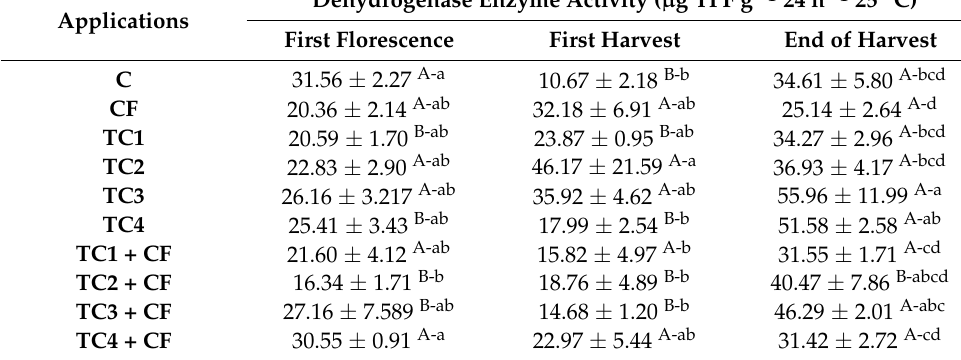
Table 8. Dehydrogenase enzyme activity values.